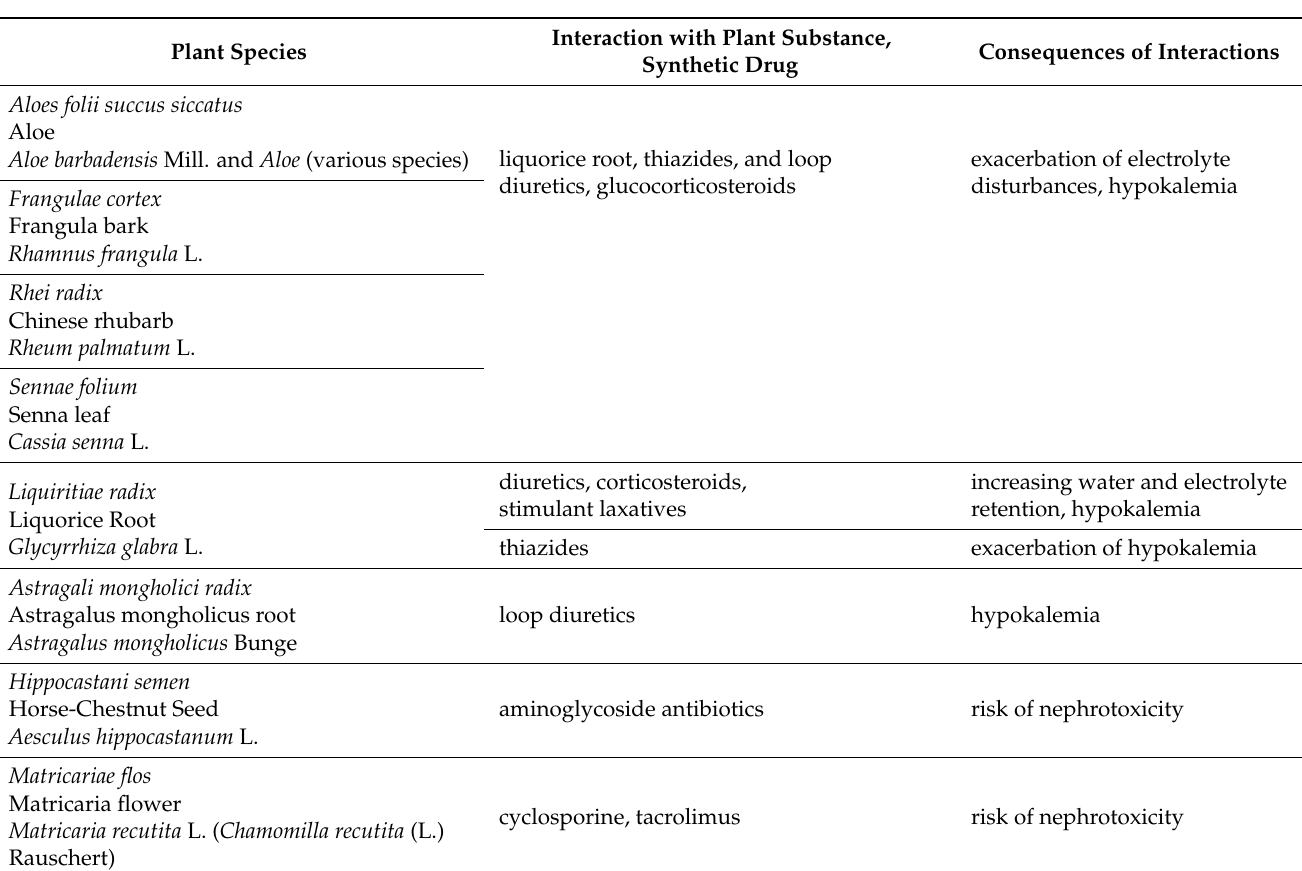
Table 4. Adverse drug interactions of herbal medicinal products resulting in adverse effects on renal function and electrolyte balance.